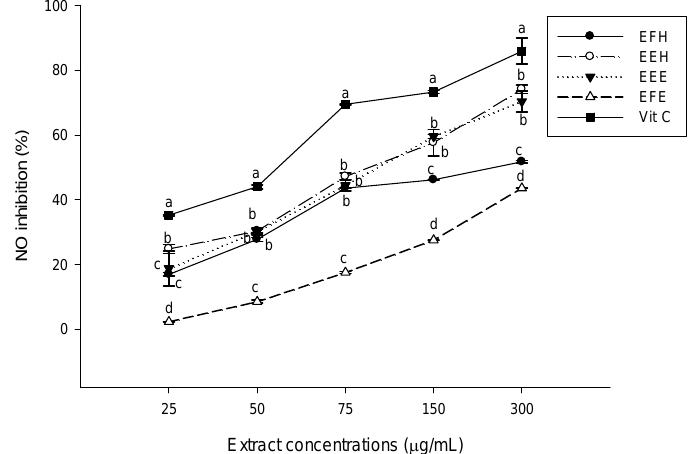
Figure 3. Nitric oxide radical (NO) scavenging potential of the different plant extracts. Values are expressed as mean ± SD of three replicates. In the same concentration the values labeled with different letters differ significantly at p < 0.05. EEE: H. zenkeri (bark) ethanolic extract; EFE: H. zenkeri (leaves) ethanolic extract; EEH: H. zenkeri (bark) hydro-ethanolic extract; EFH: H. zenkeri (leaves) hydro-ethanolic extract; Vit C: Vitamin